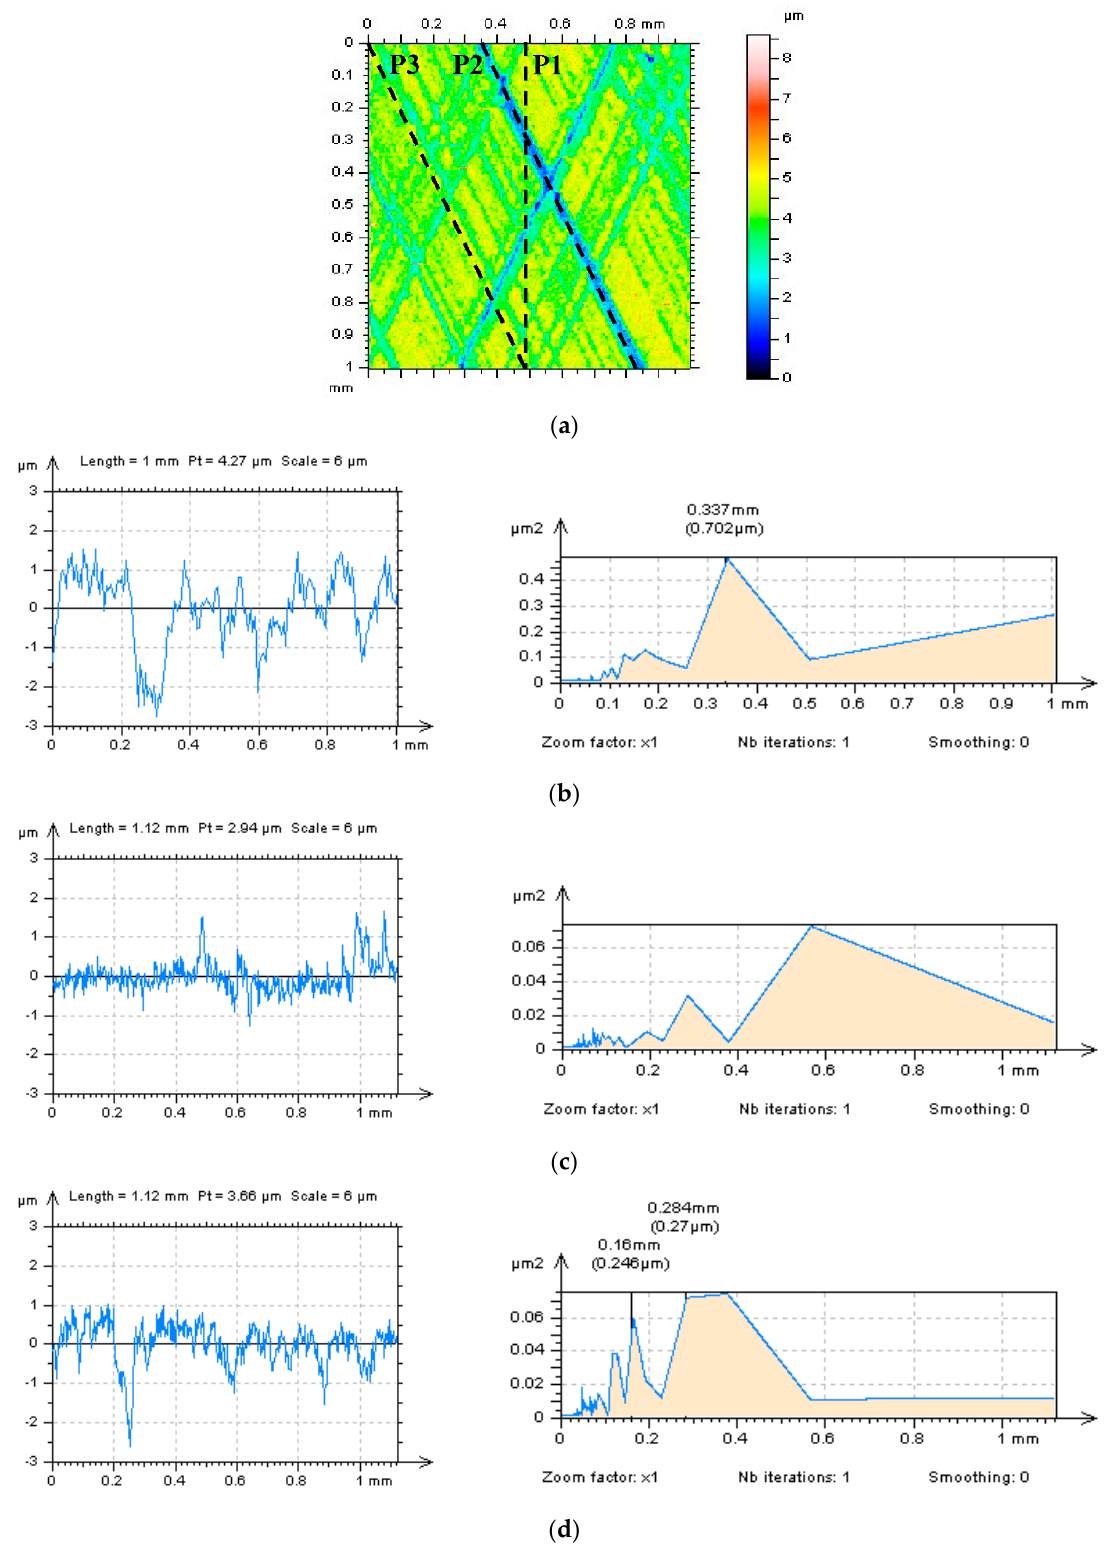
Figure 9. Isometric view ( a ) of the plateau-honed cylinder liner surface texture after stylus measurement with 0.5 mm/s velocity, and profiles P1 ( b ), P2 ( c ) and P3 ( d ) with PSDs respectively, defined for the various directions of profile extraction method.